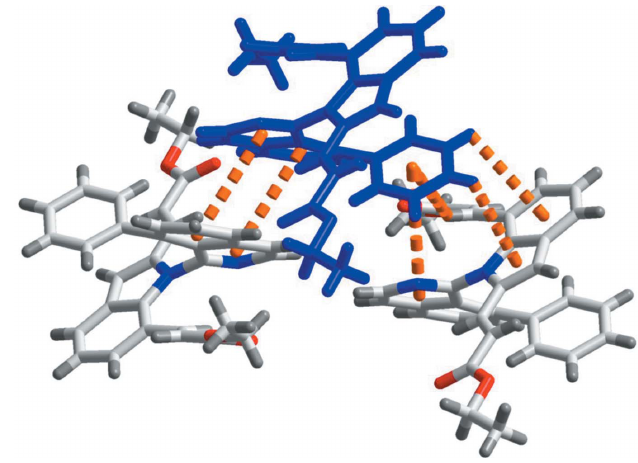
Figure 3 Partial packing diagram of the title compound, showing the (cid:2) – (cid:2) and C— H– (cid:2) interactions (red dashed lines).